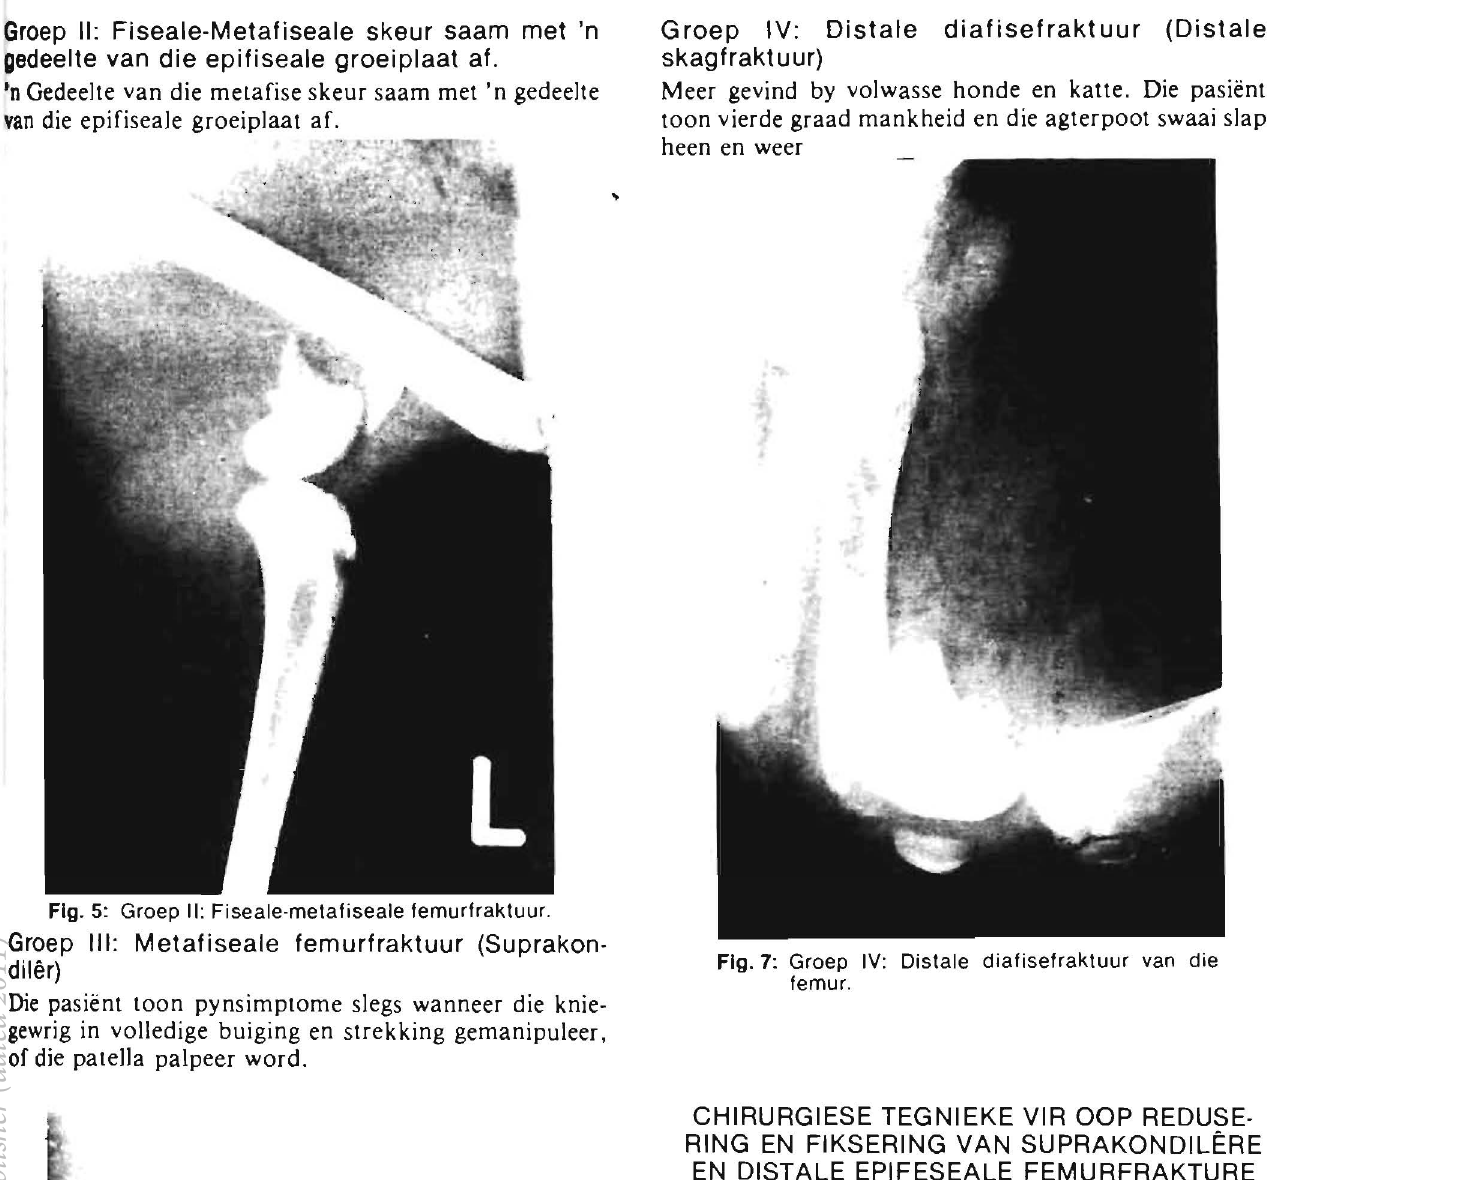
CHIRURGIESE TEGNIEKE VIR OOP REDUSE·